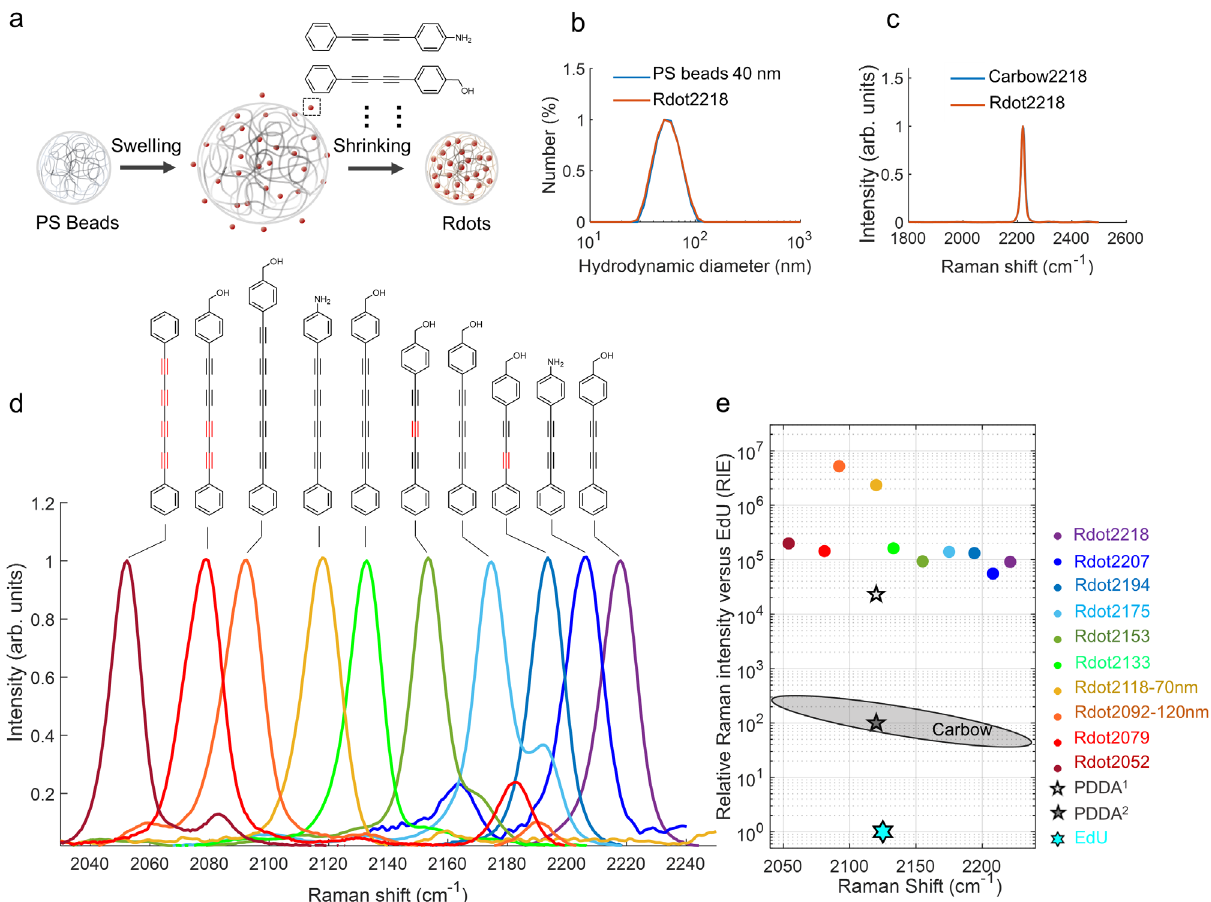
Fig. 2 Preparation and physical properties of ten-colored Rdots. a Schematic illustration of Rdots preparation via swelling-shrinking strategy. b Dynamic light scattering (DLS) size characterization of Rdot2218 before and after dye doped. c Raman spectra of Rdot2218 in water and free Carbow2218 dye in DMSO. d Normalized spontaneous Raman spectra of ten-colored Rdots, with corresponding doped dye structure listed above. e RIE values and Raman peak positions of ten-colored Rdots. Most Rdots exhibit tremendously high RIE values over 10 5 , at least 5 times larger than PDDA 36 . Due to the volume effect, Rdots with larger sizes (70 nm and 120 nm) have an RIE value over 10 6 . RIE values were measured with a spontaneous Raman spectrometer with 532 nm excitation. PDDA 1 is the RIE value detected under the resonance Raman effect. PDDA 2 is the RIE value detected without resonance